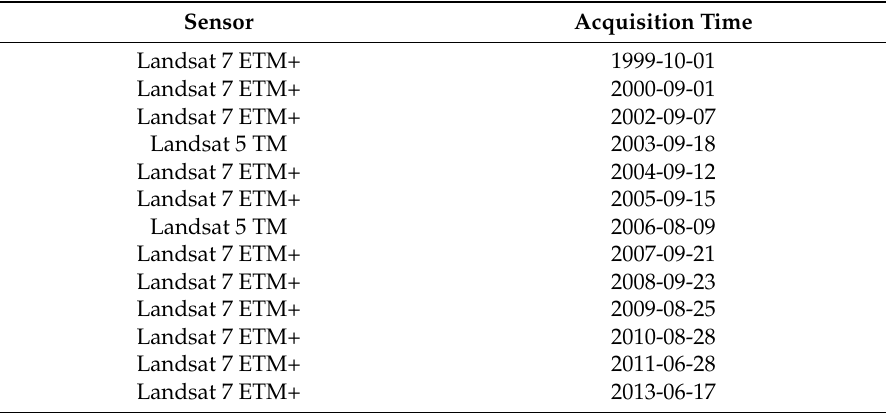
Table 1. Sensor and acquisition time of the Landsat images used in the